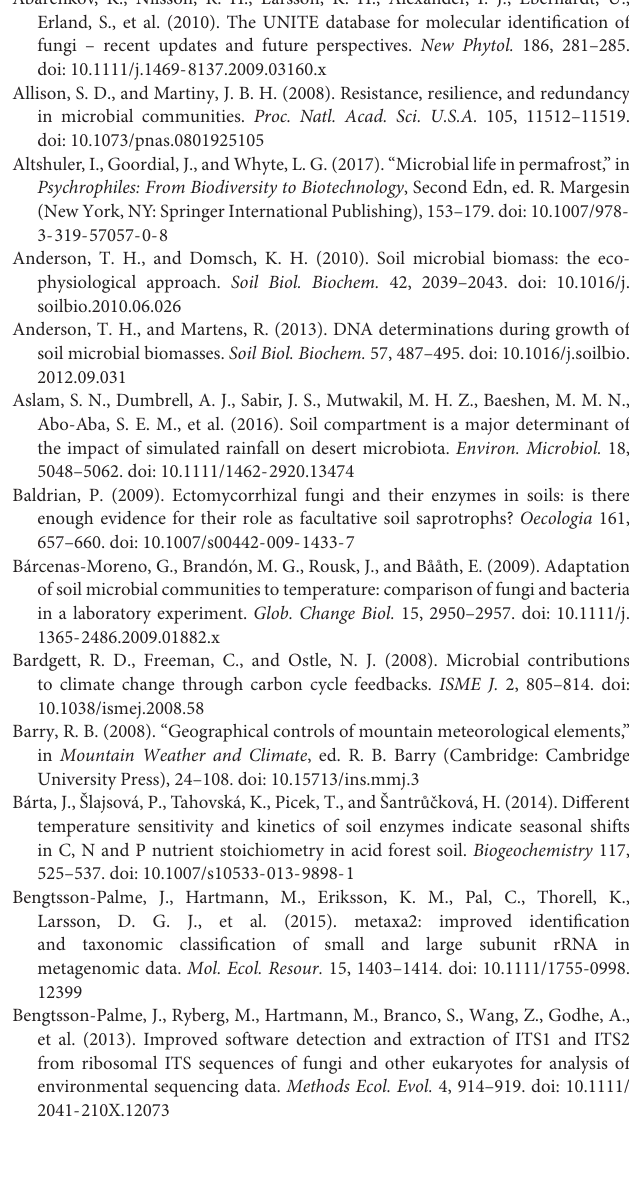
FIGURE S1 | Non-metric multidimensional scaling (NMDS) analyses of Bray-Curtis dissimilarities distances of carbon utilization patterns (Biolog) in (A) SE and (B) NW soils (active layer). Each ordination shows the combination of constrained carbon sources for each temperature after acclimation and changes after heat shock. Displayed carbon sources shifted significantly from recalcitrant to more easily decomposable ones after exposure to 40 ◦ C: NW (pseudo-F PERMANOVA = 3.65, p < 0.001) and SE (pseudo-F PERMANOVA = 7.71, p < 0.001).